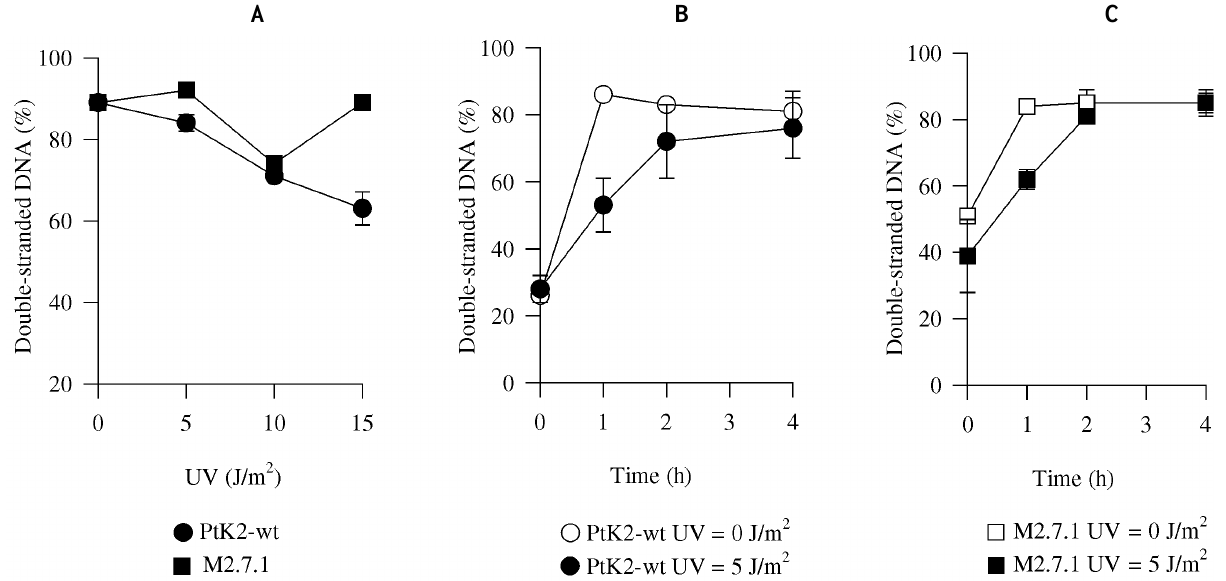
Figure 2 - Determination of nascent chain elongation. PtK2 (circles) and M2.7.1 (squares) cells were irradiated with indicated UV doses, maintained in their original medium for 1 h, then incubated with 3 H-thymidine. Cells were then incubated for 3 h or for the time indicated in fresh medium with dNTPs and prepared for BNDC-chromatography. A : UV dose response; B : PtK2 time course - 0 J/m 2 (open circles) and 5 J/m 2 (closed circles); C : M2.7.1 time course - 0 J/m 2 (open squares) and 5 J/m 2 (closed squares). wt, Wild-type cells.